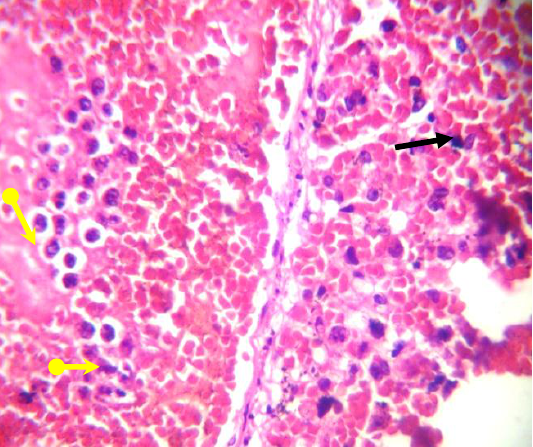
Fig 6: Microscopic section of rabbit lung from 1st immunized group at 3 days post challenge show severe congestion of blood capillaries with PMNCS infiltration (H&E